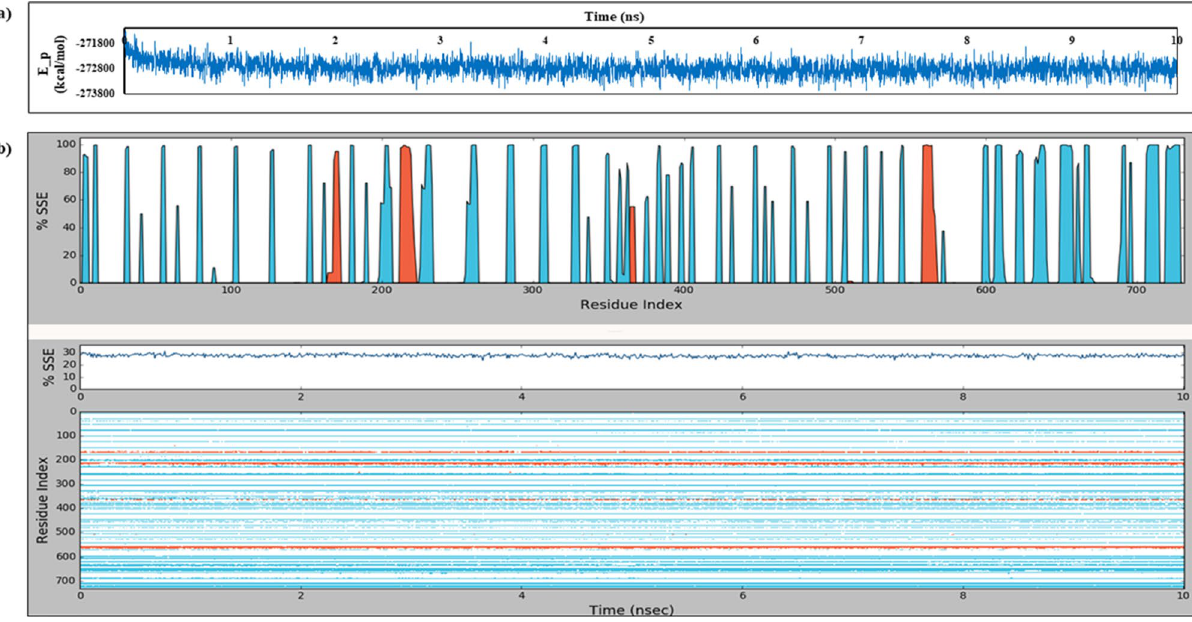
Figure 4. Desmond MD simulation outputs of mouse TLR4-MD2-FN-EDA ( a ) E_p (potential energy) plot vs simulation time; ( b ) TLR4-MD2 secondary structure changes during simulation where light blue refers to β-strands and orange colour refers to